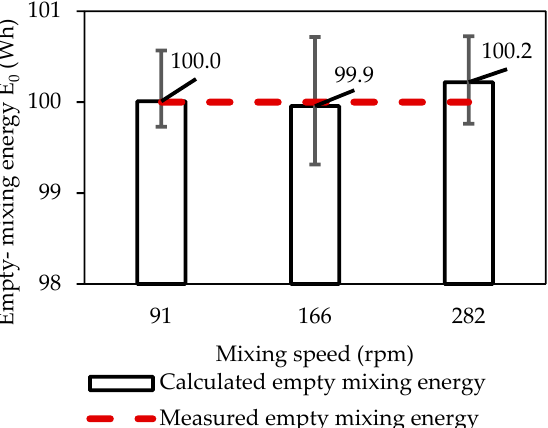
Figure 4. Validation of the mixing energy E 0 for the empty running Omcan SP300AT mixer: comparison between calculated and measured values.